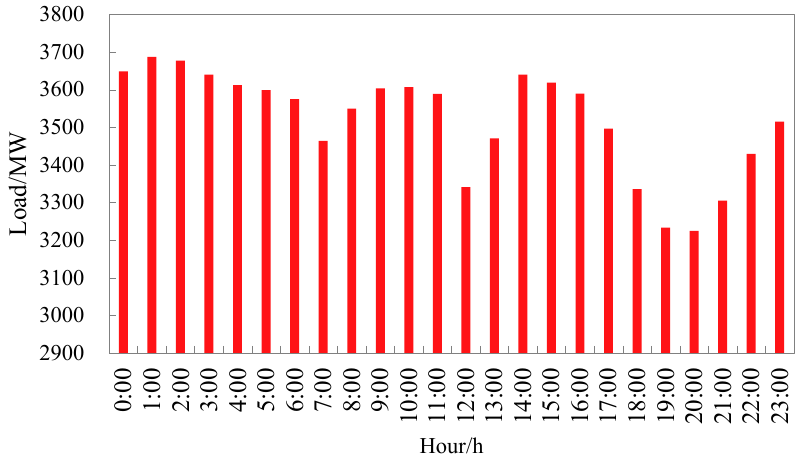
Figure 7. The clustering of the typical daily load curve for the entire year. Then, the TOU tariff was calculated, as shown in Table 9. Table 9. The TOU tariff optimization result based on the traditional TOU optimized model. Peak Flat Valley Original tariff